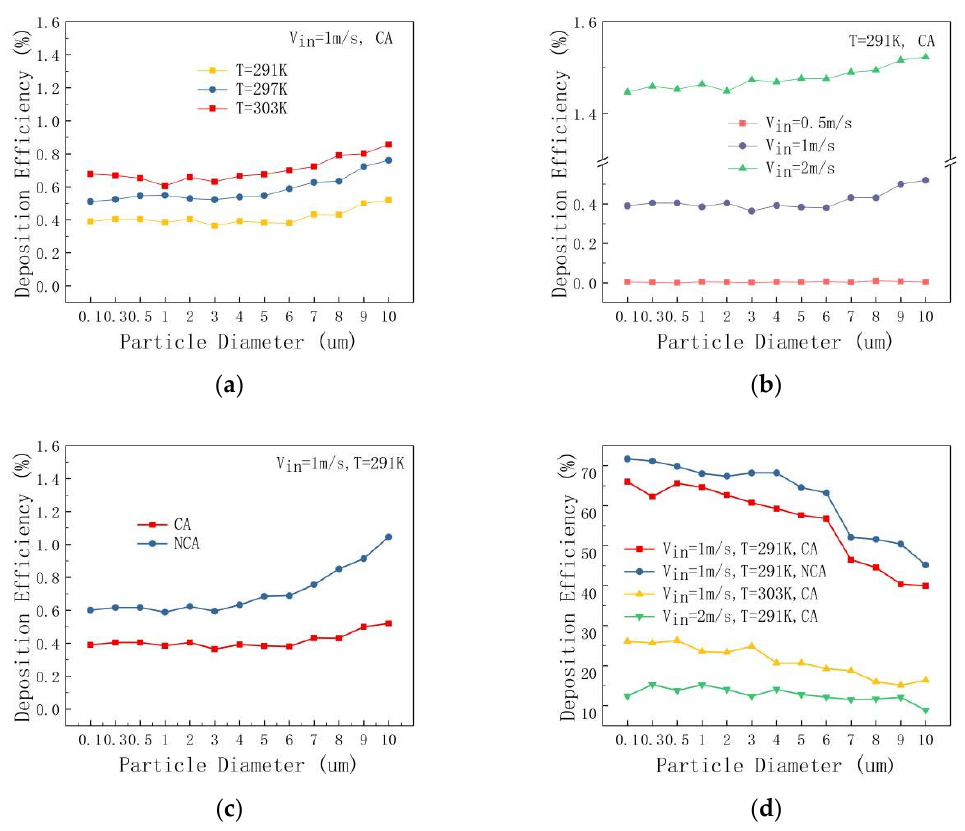
Figure 8. Wind velocity, temperature, and respiratory tract effect on particulate deposition in healthy humans: ( a ) DE at different wind speeds; ( b ) DE at different temperatures; ( c ) DE in the absence of respiratory tract; ( d ) Exposure to risk.